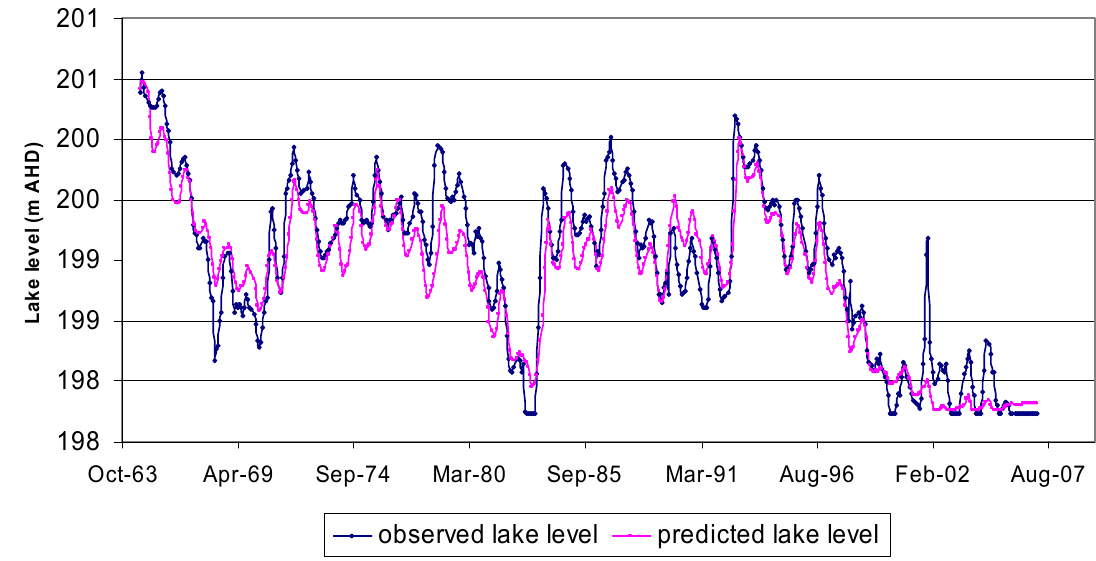
Figure 11. Lake Linlithgow measured water levels and a comparison to modeled results for the period 1964–2007.